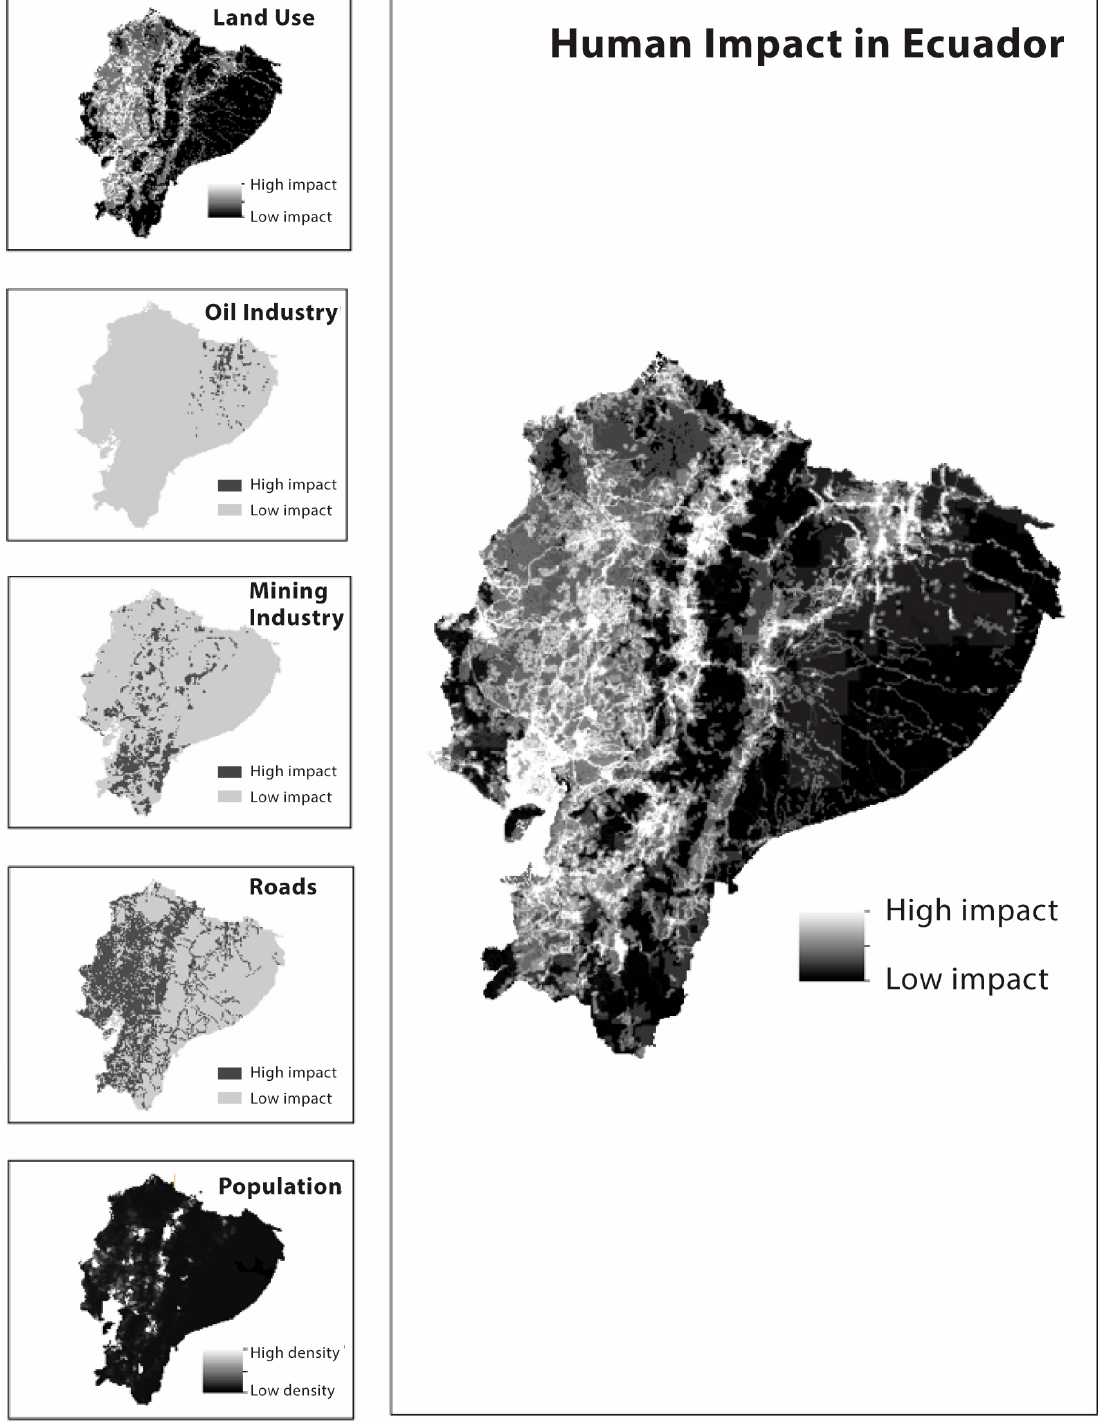
Figure 238. Human impact on ecosystems of Ecuador.